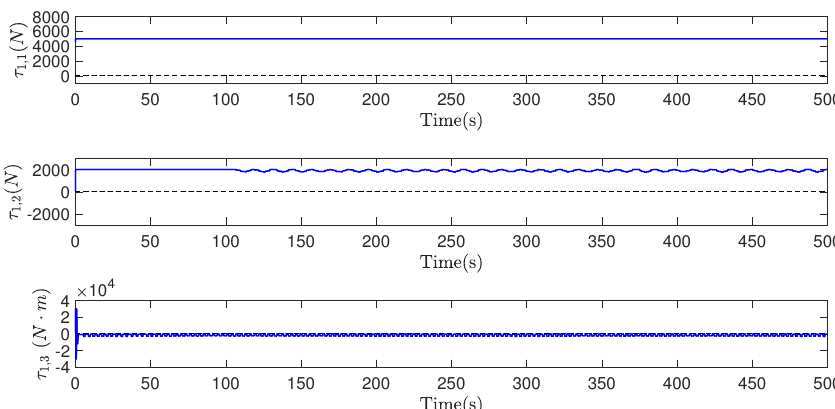
Figure 7. τ 1 , control inputs of airship A 1 , in former 500 s.